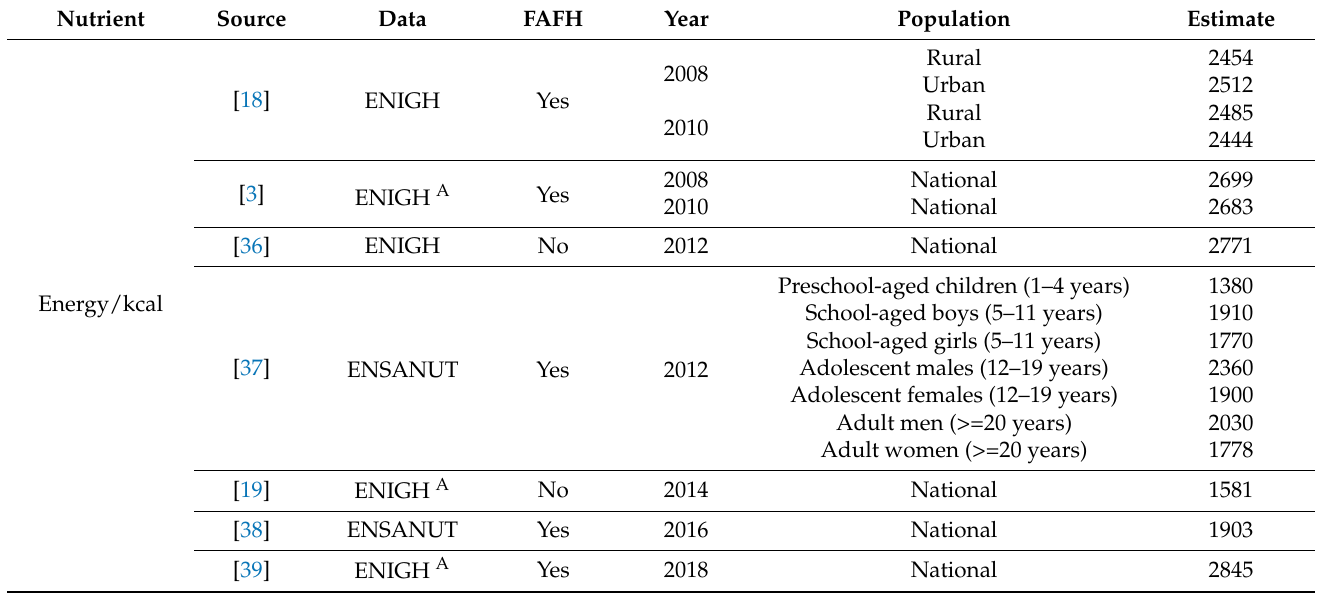
Table 4. Previous estimates of nutritional availability and intake, M é xico